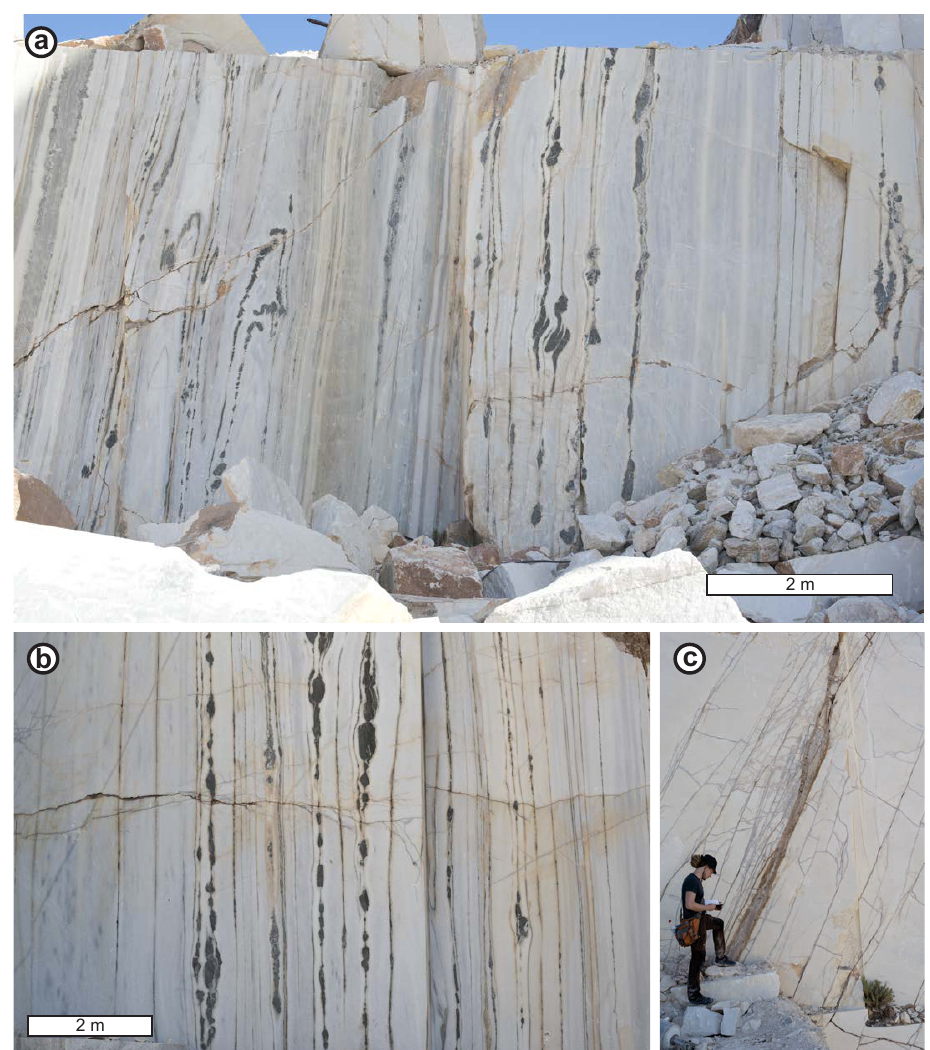
Figure 5. Examples of vertical wall exposures. (a) Isoclinal folds and pinch-and-swell boudins in a wall close to Location 7, view to the north. Banding of the marble is parallel to the amphibolite layers. (b) Pinch-and-swell structures in vertical walls result from the combination of lλ and sλ pinch-and-swell sets. In layer-normal 2-D sections it is challenging to distinguish between the two generations (Location 20, view to the south). (c) E–W-trending normal fault in the marble with a pronounced damage zone. The fault is filled with calcareous sinter (close to Location 8, view to the